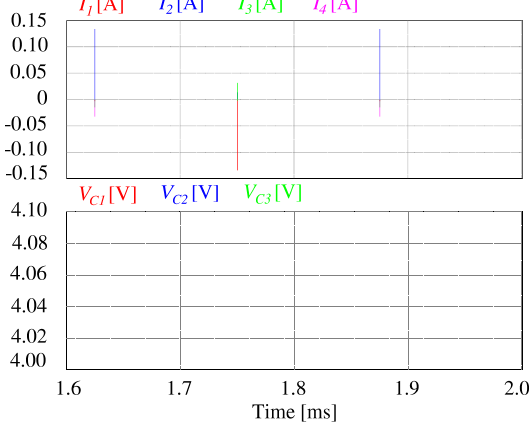
Figure 11. Zoom of the current in the cells and voltage of the capacitors in the switched capacitor